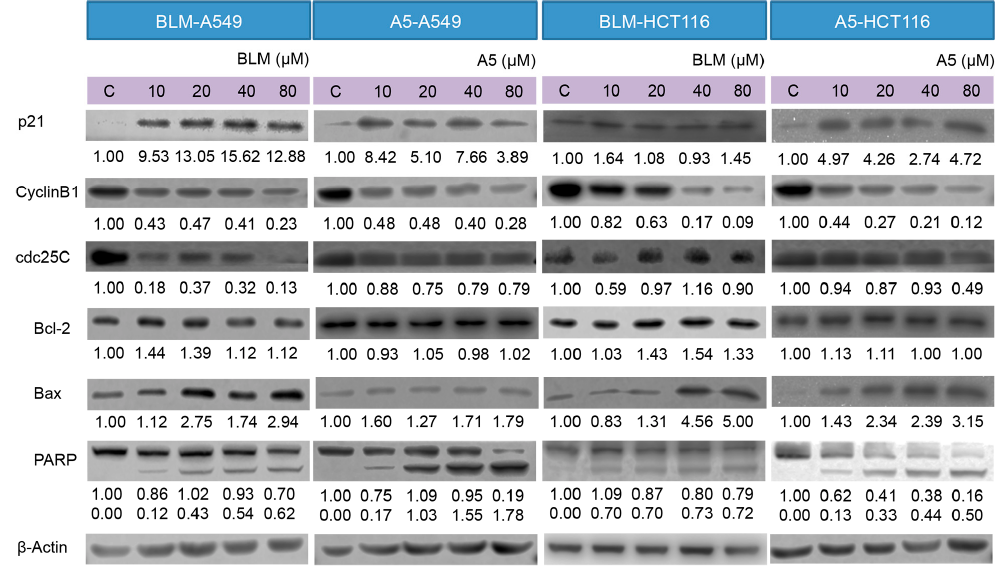
Figure 5. Effects of BLM and A5 on cell cycle and apoptosis related proteins in A549 and HCT116 cells. Cells were treated with the indicated concentrations of BLM or A5 for 24 h. In addition, 50 μ g cell lysates were prepared, resolved over SDS-polyacrylamide gel electrophoresis, transferred to nitrocellulose membrane, and immunoblotted with antibodies to detect Bcl-2, Bax, cdc25C, cyclin B1, and p21. The numbers underneath the blots represent band intensity (normalized to β -Actin, the means of three independent experiments) measured by Image J software (National Institutes of Health, USA). The standard deviations (all within ±15% of the means) were not shown. β -Actin served as an equal loading control. Data are representative of three independent experiments with similar results.